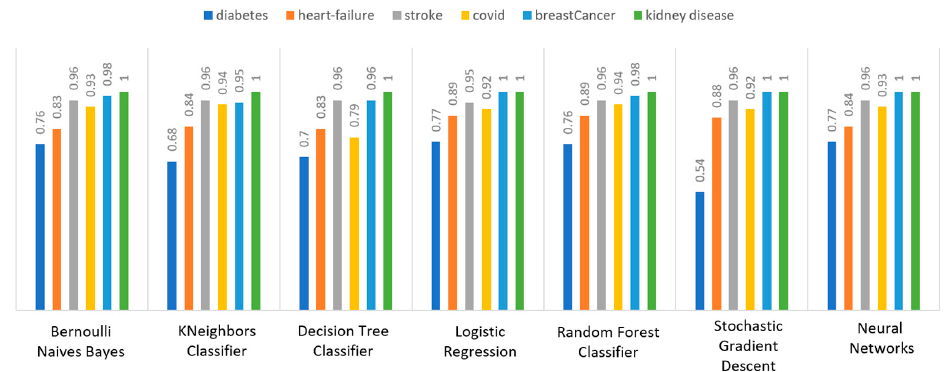
Figure 12. Recall results of ML models for each use case.